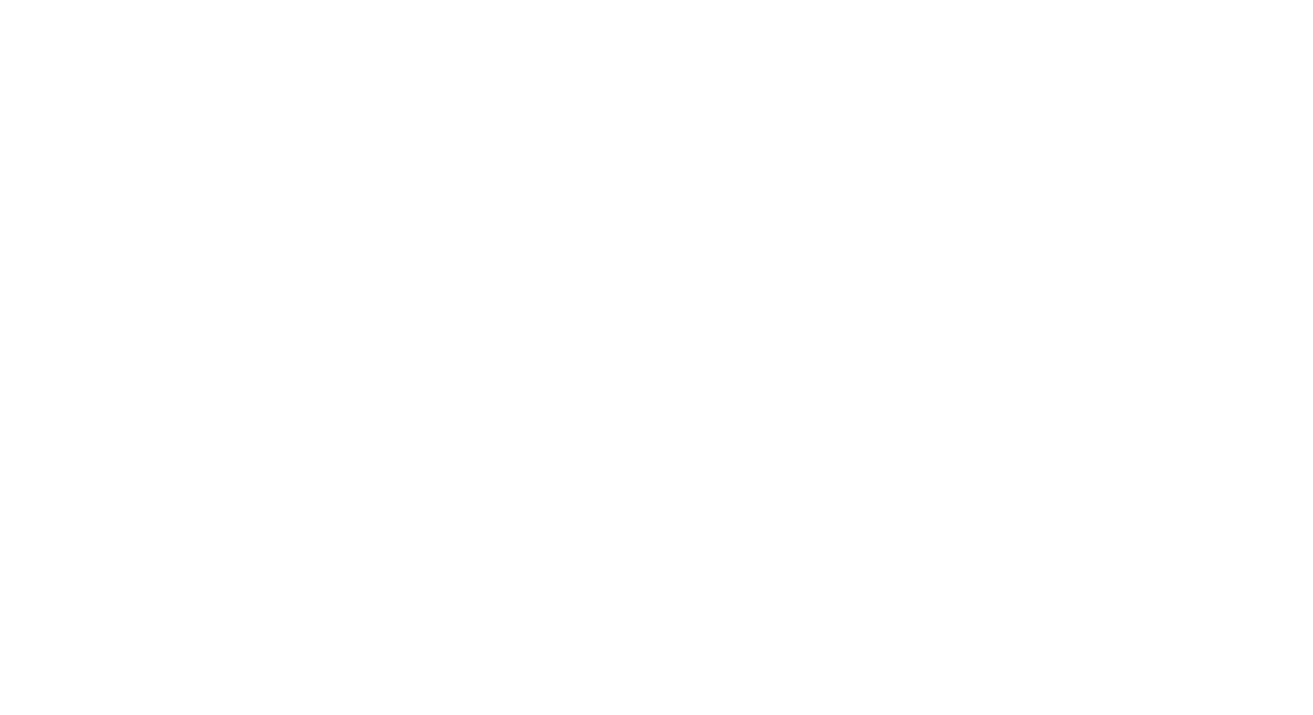
Frontiers in Nutrition | www.frontiersin.org